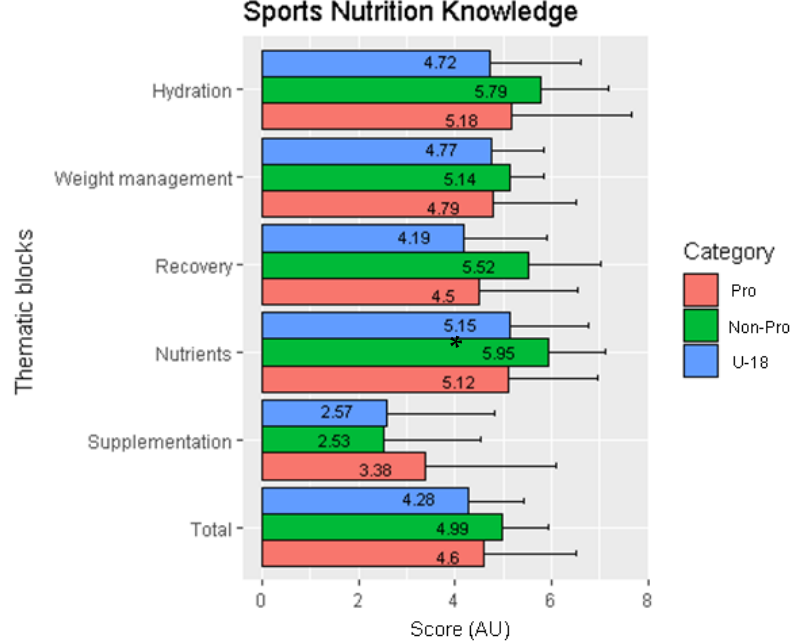
Figure 1. Sports nutrition knowledge (thematic blocks). Legend: * statistical significance differ- ence.